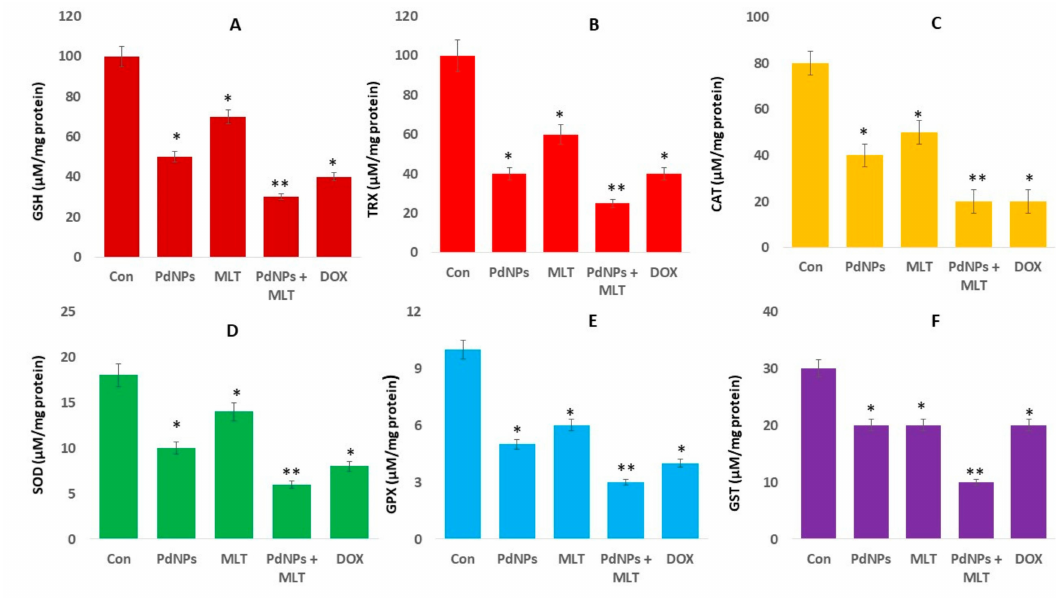
Figure 7. E ff ect of PdNPs + MLT on antioxidant markers. A549 cells were incubated with PdNPs (2.5 µ M), MLT (0.75 mM), PdNPs and MLT (2.5 + 0.75 mM), or DOX (5.0 µ M) for 24 h. After